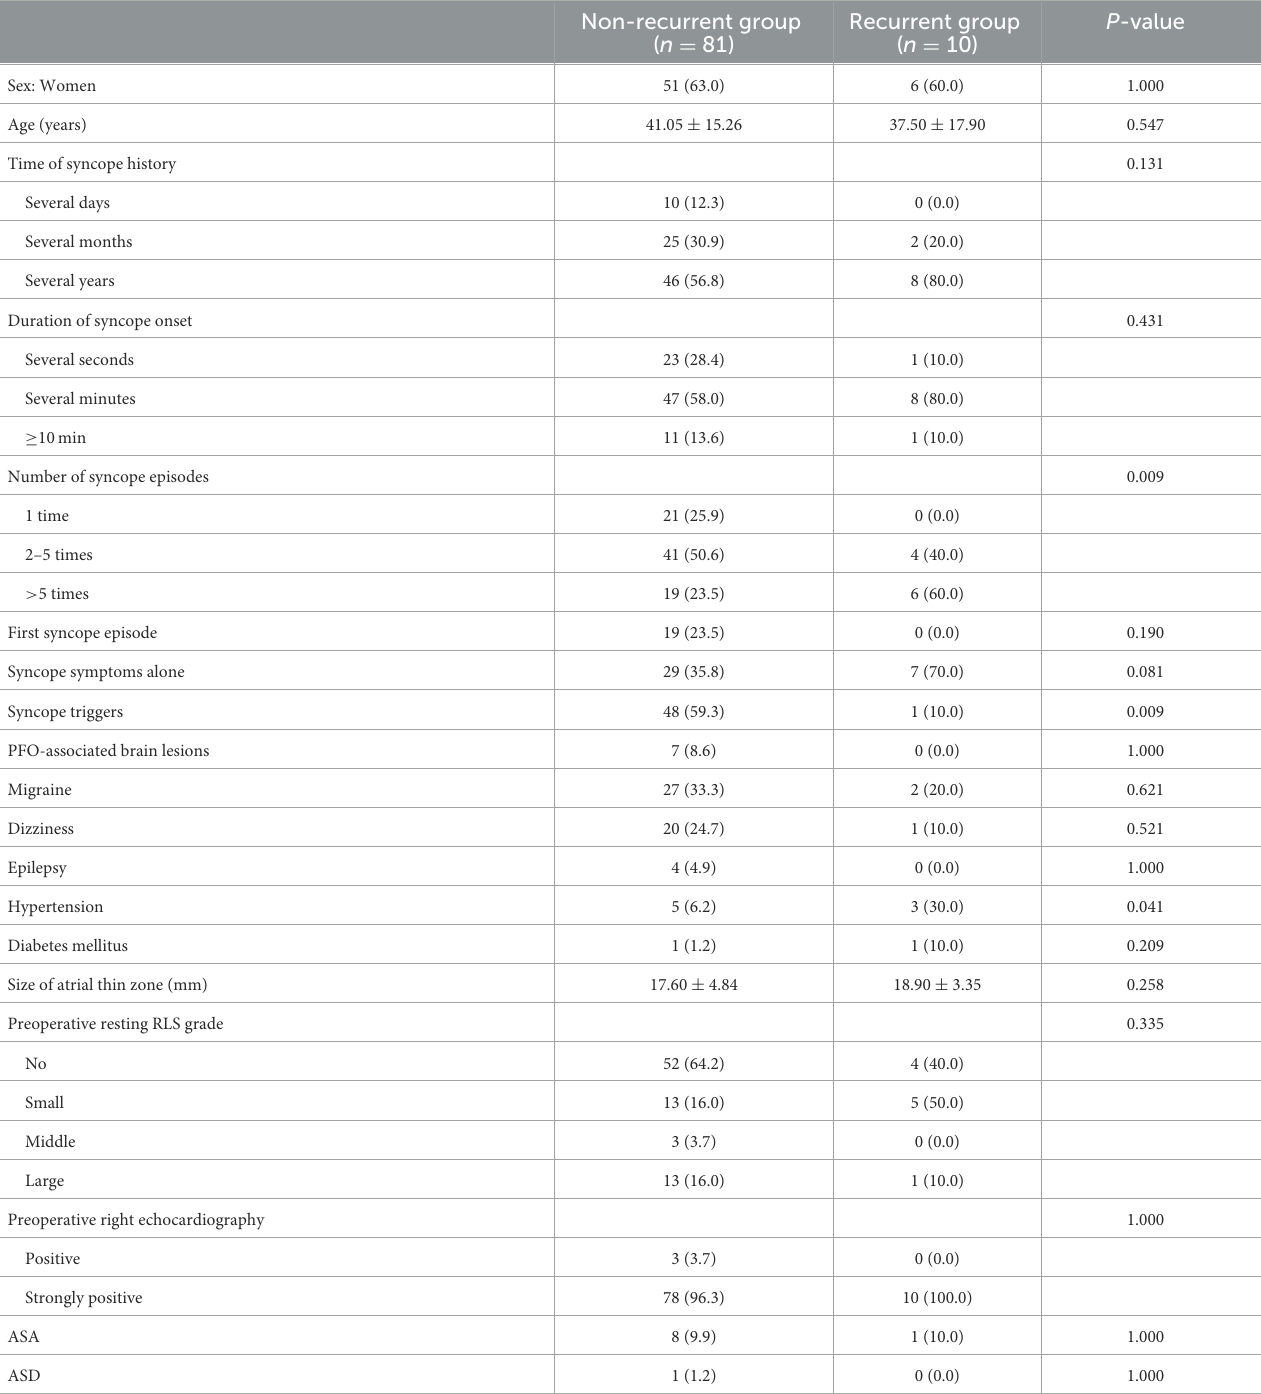
TABLE 3 Comparisons of baseline data and ultrasound characteristics between the non-recurrent group and the recurrent